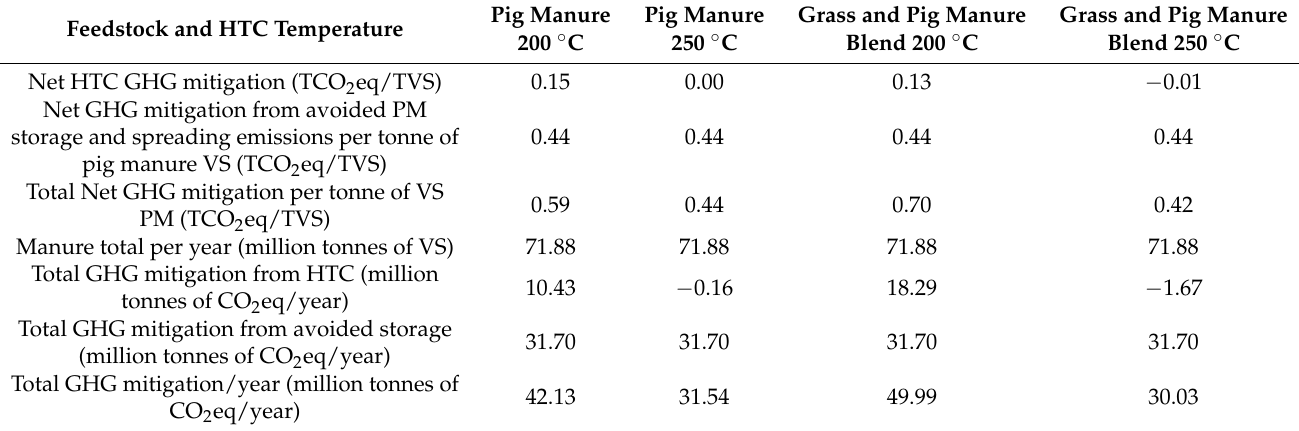
Table 6. Chinese GHG mitigation from HTC of PM and PM-grass